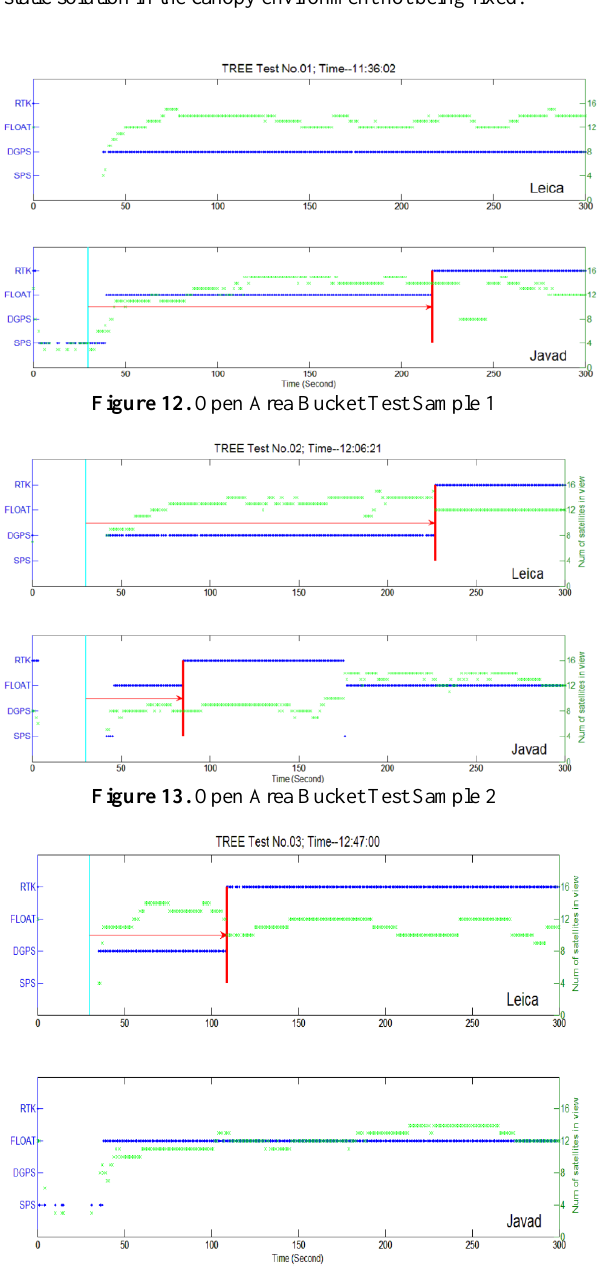
Figure 15. Vegetation Area Bucket Test Sample 1